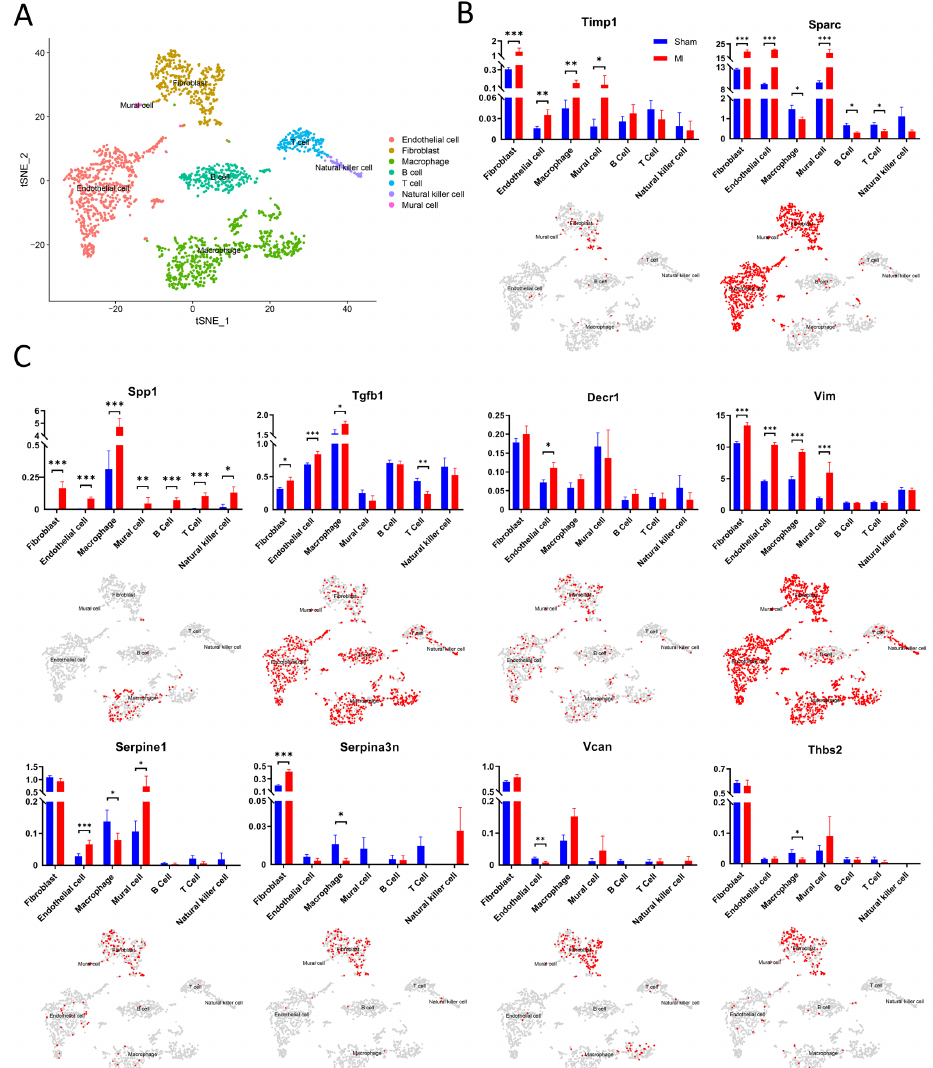
Figure 6. Single-cell sequencing of TIP from hearts after myocardial infarctions. ( A ) t-SNE plots of aggregated cardiac TIP 7d after infarction surgery; ( B , C ) expression of hub genes in different populations and localization in t-SNE plots. Blue color indicates sham surgery group, red indicates infarction surgery group. * p < 0.05, ** p < 0.01, *** p < 0.001, Mann-Whitney U test.